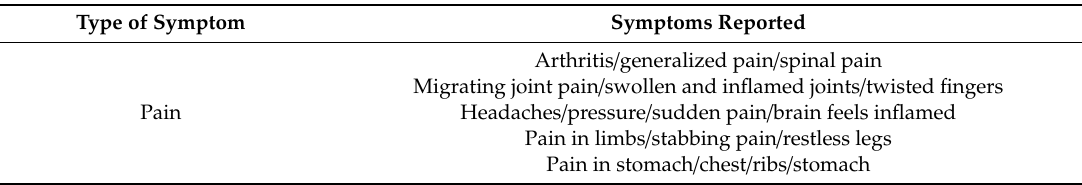
Table 2. List of reported early